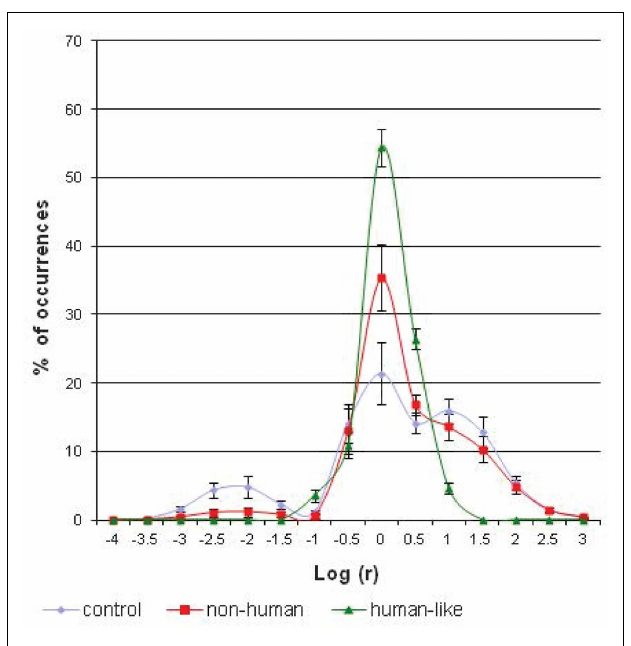
FIGURE 6 |The average distribution of (logarithms of) curve radii, expressed as a percentage of the total number of occurrences, following the three experimental conditions of anticipation. The percentage of occurrences of the smallest spike of curve radius (around − 2) is significantly lower ( p < 0.04) while the largest spike of curve radius (around 0) is significantly higher ( p < 0.0006) in the “human-like” mode of control, as compared with the two other robot modes of